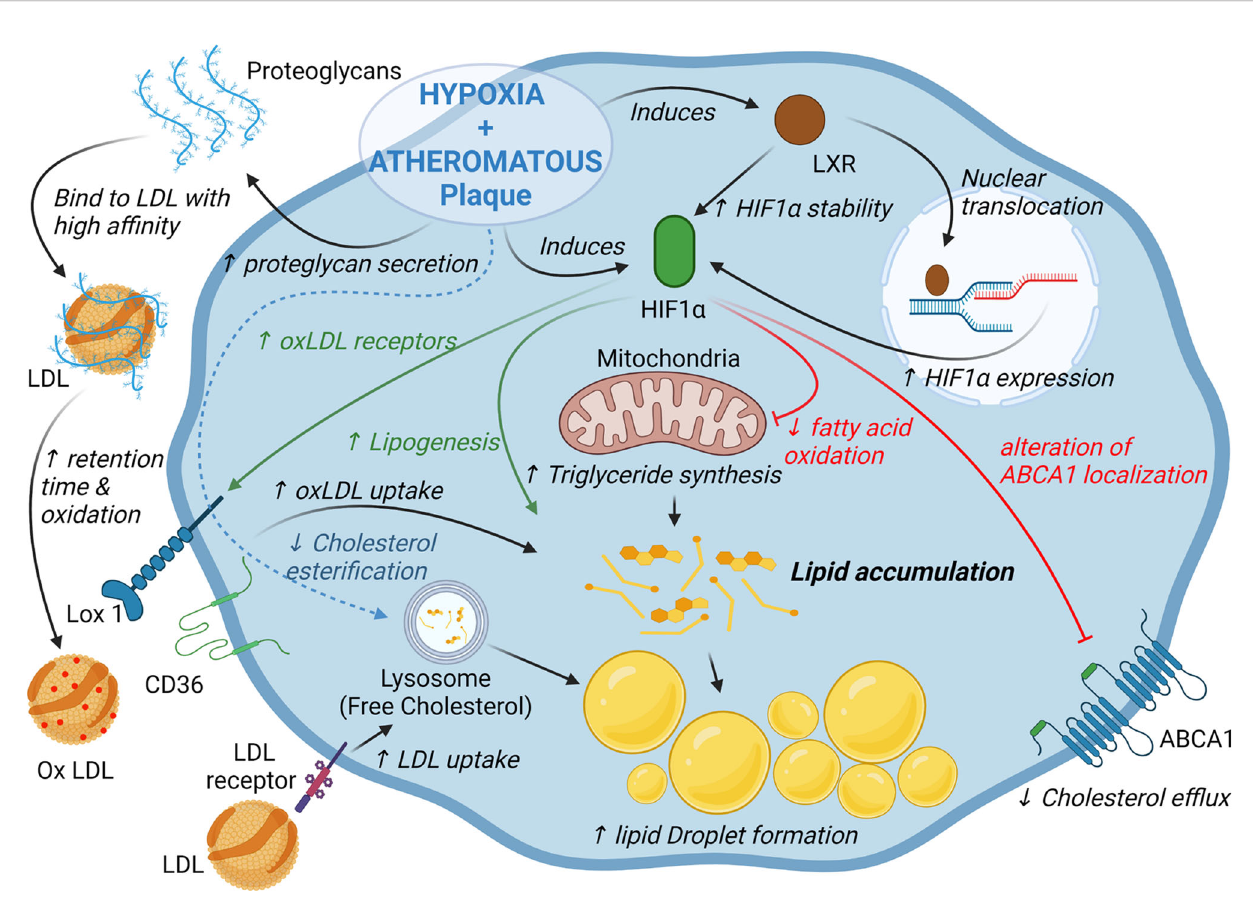
FIGURE 2 | HIF-1 a and hypoxia alter lipid homeostasis in macrophages. Activation of HIF-1 a dependent pathways promotes triglyceride and cholesterol accumulation in macrophages through activation of lipogenesis, cholesterol synthesis and decrease of fatty acid oxidation. Hypoxia and HIF-1 a also promotes low density lipoproteins (LDL) retention as well as oxidized LDL uptake by changing proteoglycan composition and increasing the expression of several scavenger receptors. Finally, in murine macrophages hypoxia/HIF-1 a impair cholesterol ef fl ux by altering ABCA1